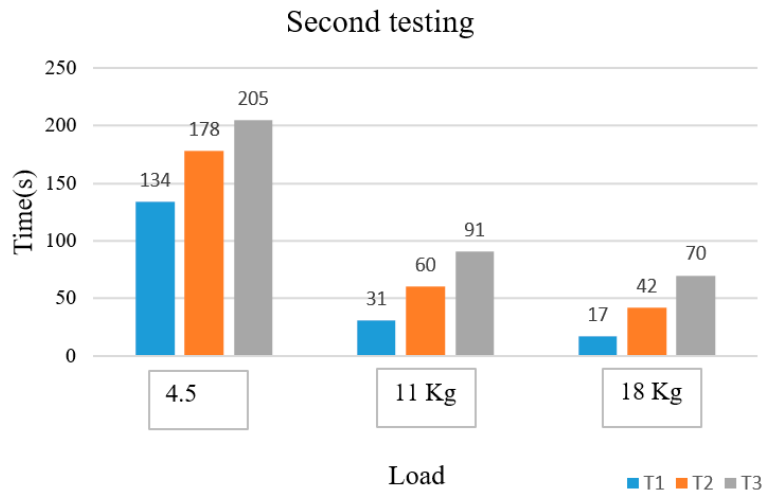
Figure 13. Time fatigue parameters with different loads in the second testing.